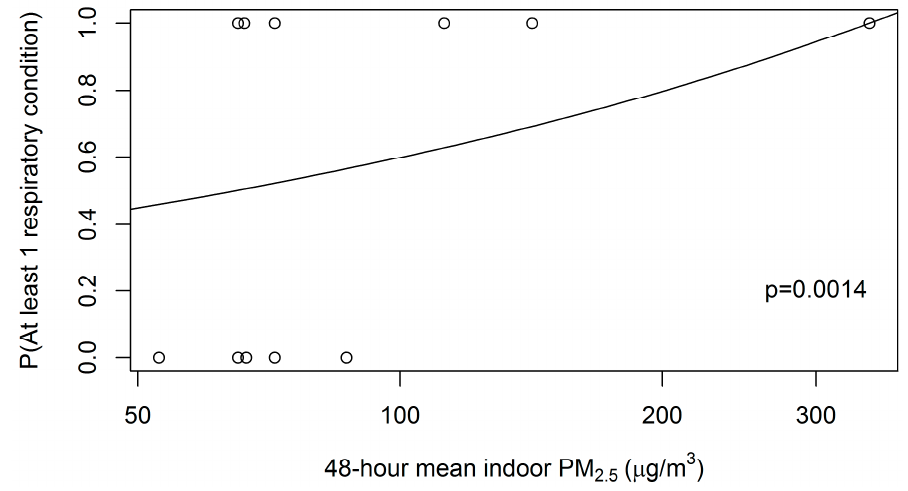
Figure 2. Fitted log-binomial model probability of child having at least one respiratory condition, among 13 children living in homes with kitchens that were not partitioned from the rest of the home. Plotted points are respiratory condition (0 = none, 1 = either of two).